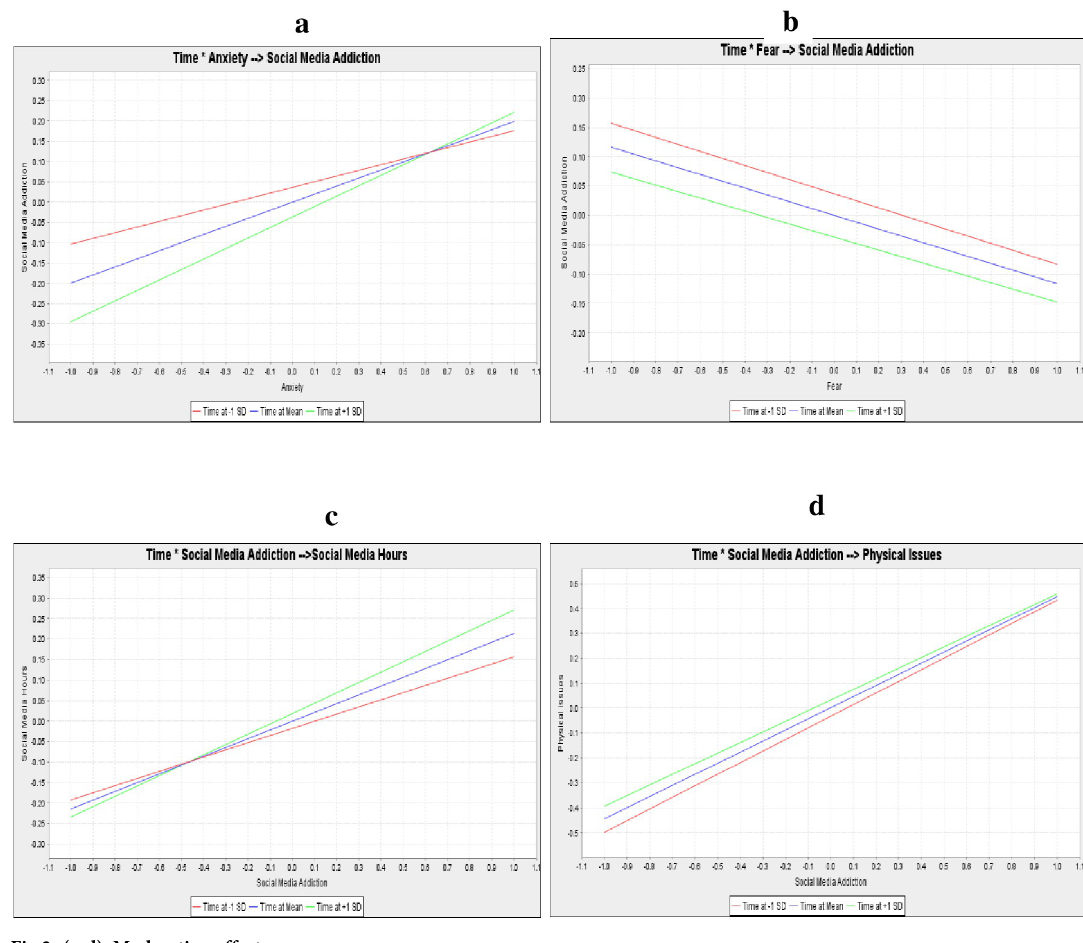
Fig 2. (a-d): Moderation